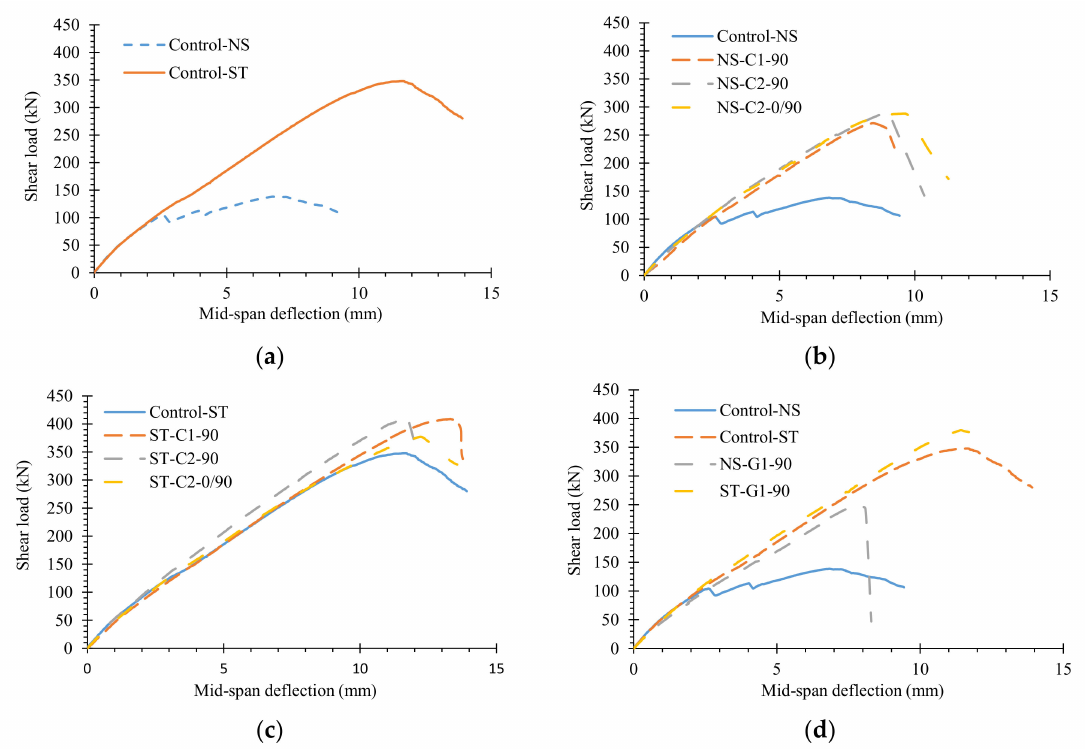
Figure 10. Experimental shear load–deflection response: ( a ) Control beams; ( b ) Group A; ( c ) Group B; ( d ) Group